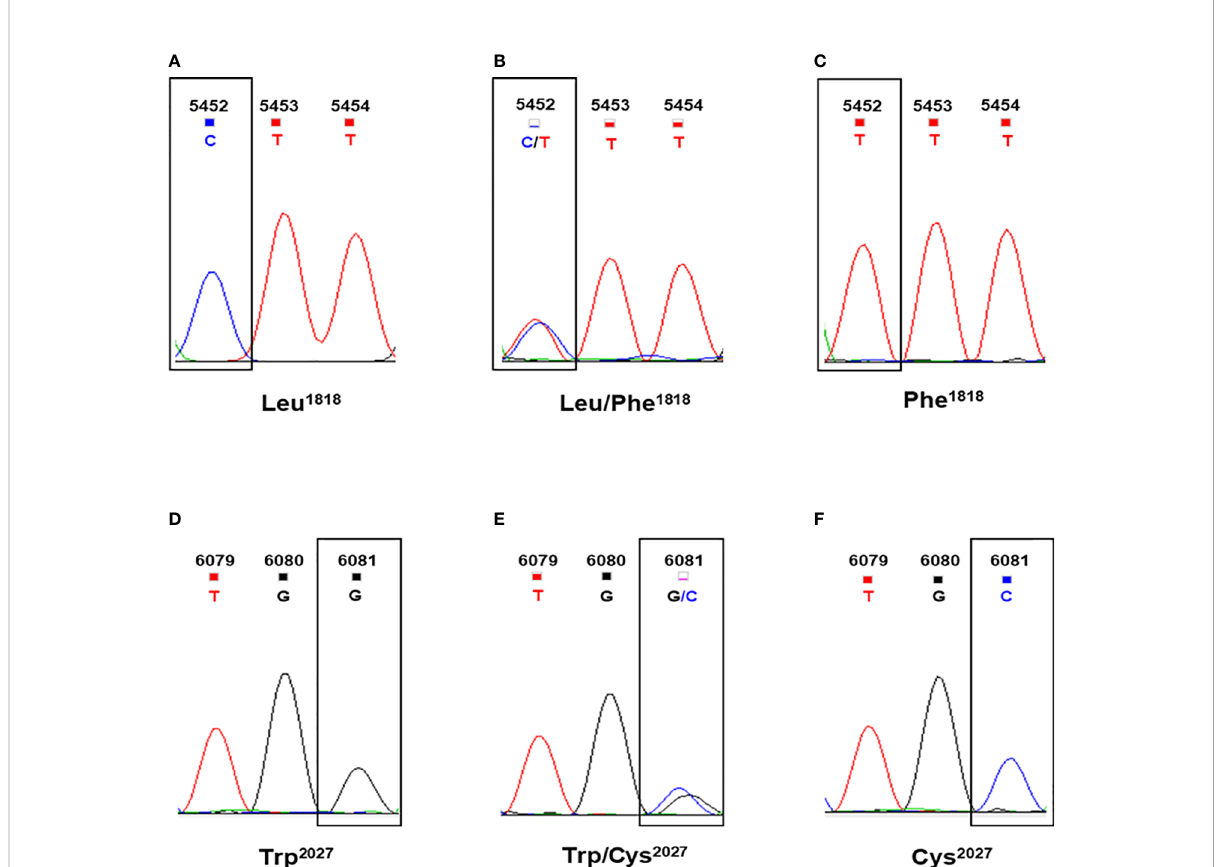
FIGURE 3 Sequences at codon position 1818 and 2027 of ACCase in Leptochloa chinensis individuals. (A) The CTT codon for Leu 1818 in wild-type plants. (B) The CTT/TTT codons for Leu/Phe 1818 in heterozygous mutant plants. (C) The TTT codon for Phe 1818 in homozygous mutant plants. (D) The TGG codon for Trp 2027 in wild-type plants. (E) The TGG/TGC codons for Trp/Cys 2027 in heterozygous mutant plants. (F) The TGC codon for Cys 2027 in homozygous mutant plants.